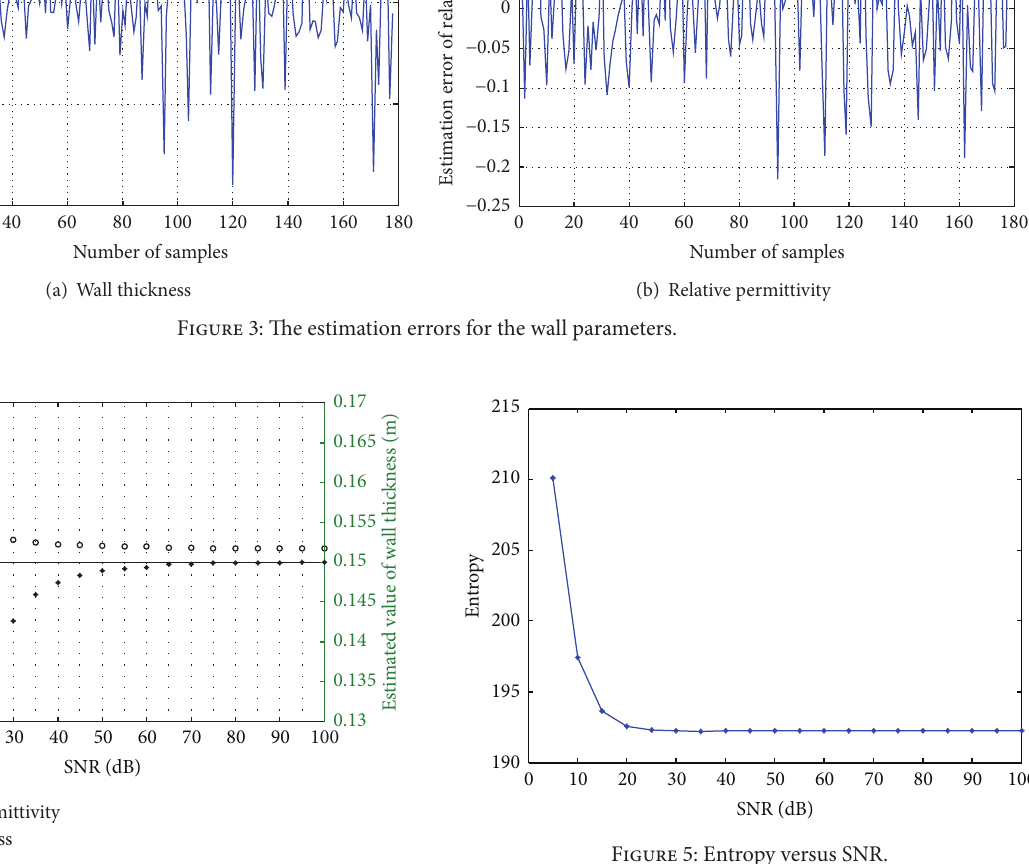
Figure 4: Estimated values of the wall parameters versus SNR.